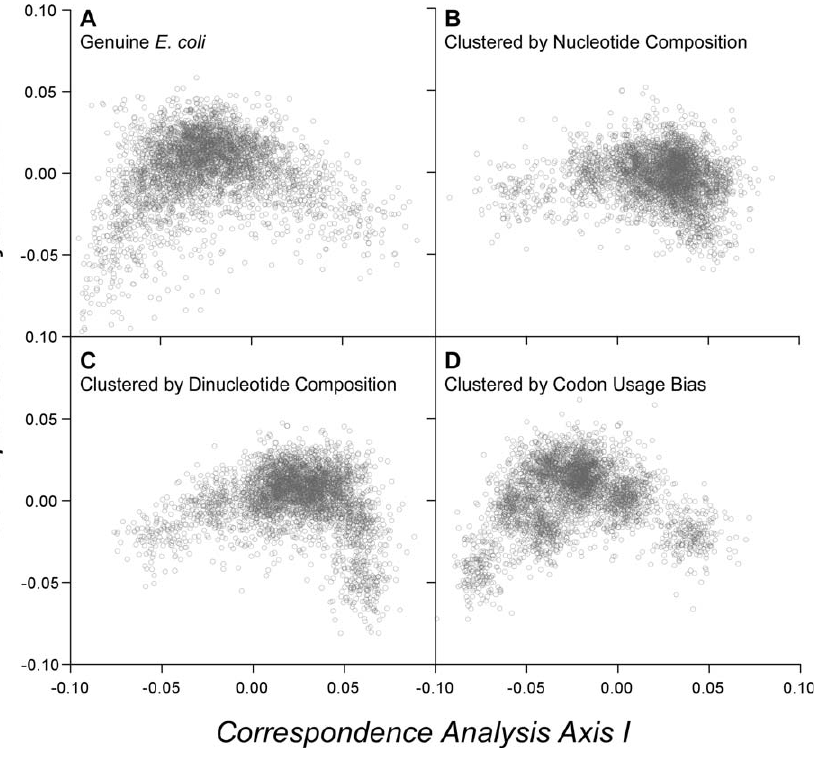
Figure 4. Correspondence Analysis of CUB The first axes—indicating variability in usage among 59 synonymous codons—are plotted for genuine E. coli genes (A) and genes from artificial genomes (see Figure 2) created from gene models sampling groups of genes clustered by SNC (B), DNC (C), or CUB (D) criteria. DOI: